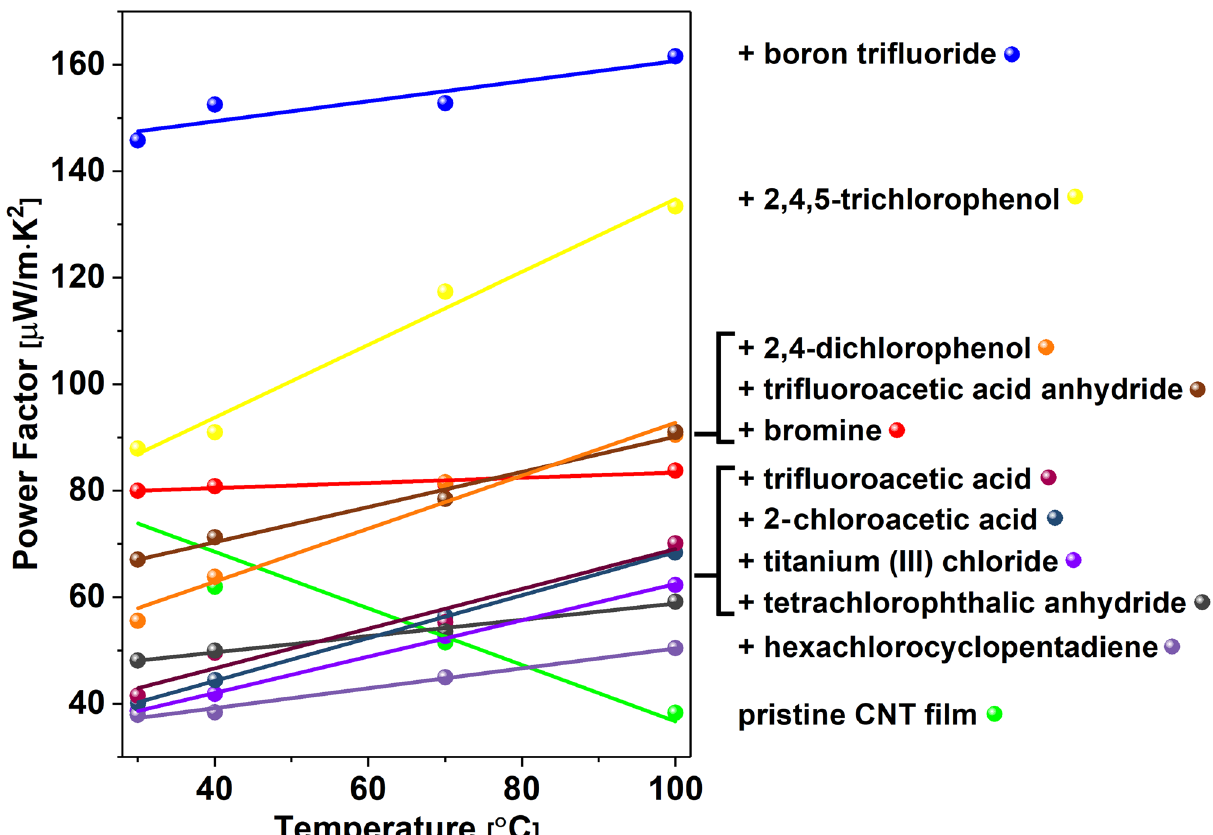
Figure 6. Power Factors at different temperatures for a pristine CNT film and CNT films after doping with halide compounds. Lines were added to guide the eye through a selected group of